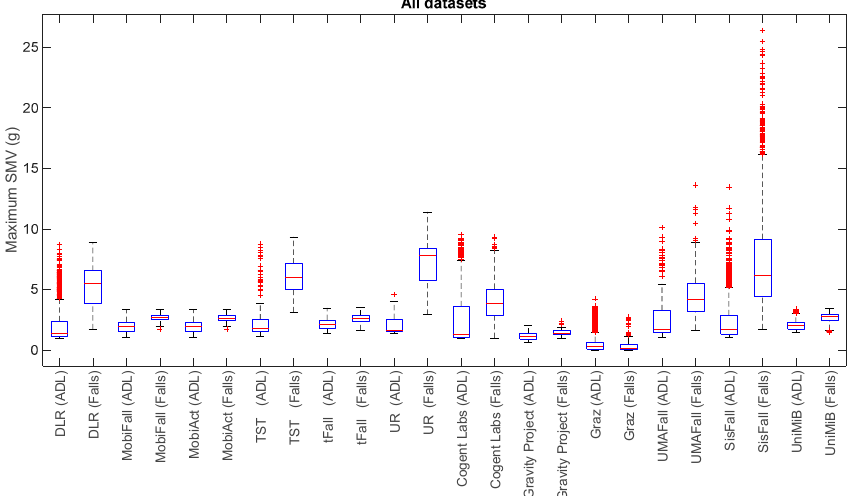
Figure 1. Boxplots of the of the maximum acceleration module for the falls and ADLs of all the datasets (for all the datasets only the acceleration signal at the waist or—if not available—at the thigh is considered).